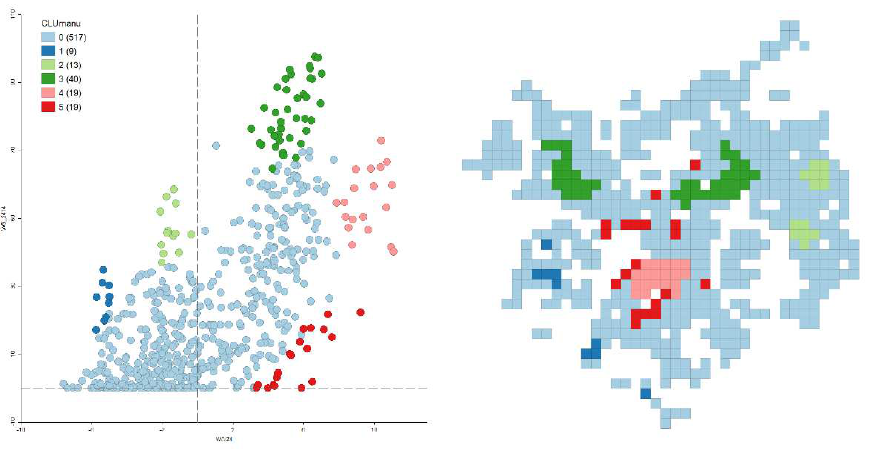
Figure 12. Outliers in WAI—WS relationship and their location in Ostrava.